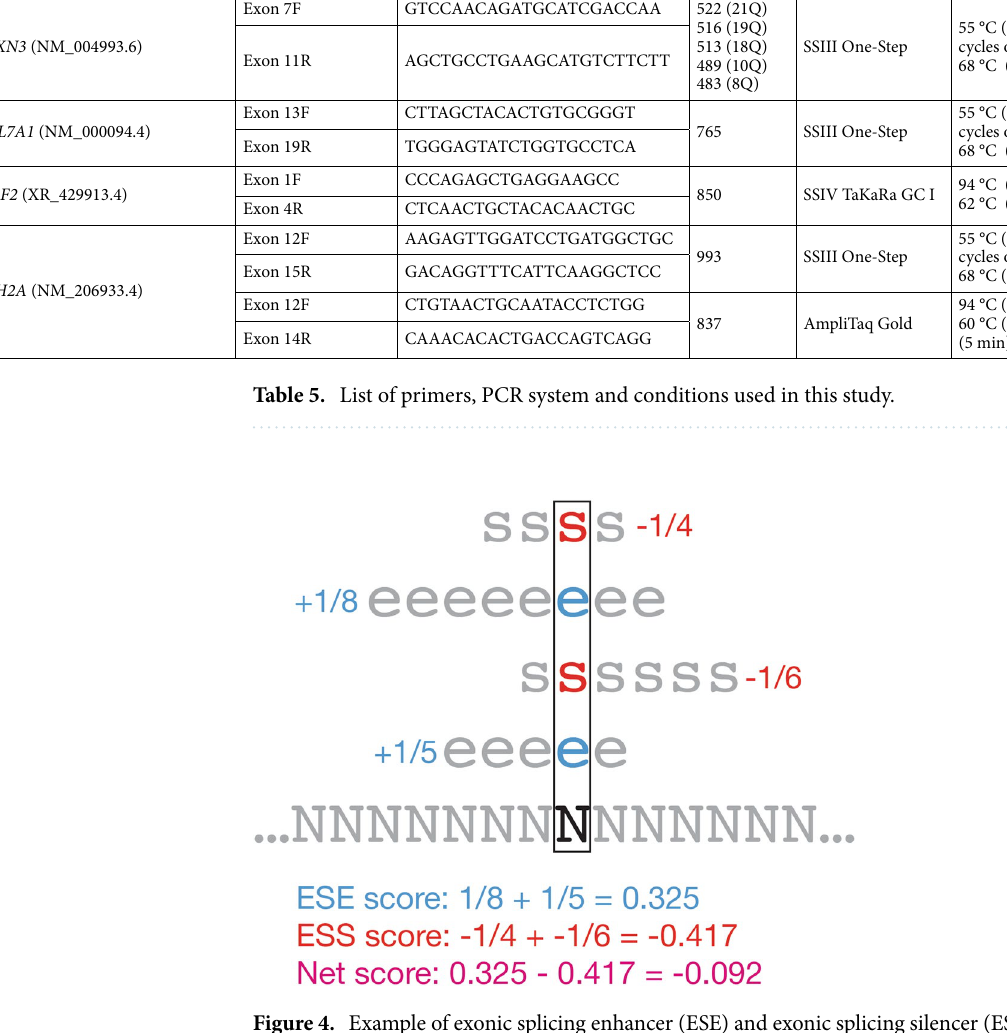
Figure 4. Example of exonic splicing enhancer (ESE) and exonic splicing silencer (ESS) score calculations for an RNA nucleotide. An RNA nucleotide, N, indicated with a rectangular box, is assigned an ESE score as the sum of its contributions to any overlapping enhancer motifs, indicated with ‘e’ characters and blue text, and an ESS score as the sum of its contributions to any overlapping silencer motifs, indicated with ‘s’ characters and red text. The ‘Net score,’ shown in purple text, is determined as the sum of the ESE and ESS scores